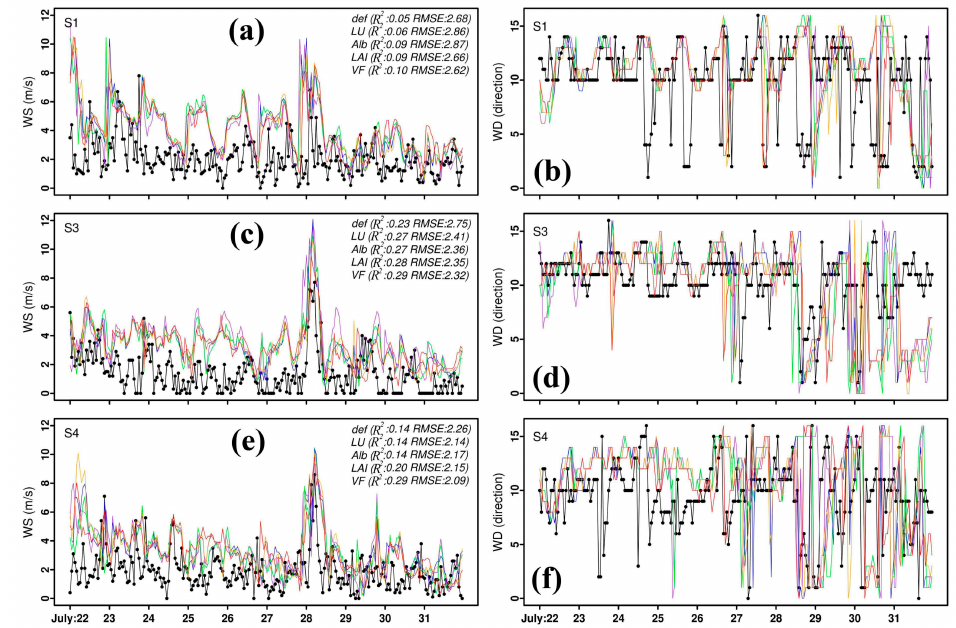
Figure 10. Comparisons of hourly 10 m ( a , c , e ) wind speed (WS) and ( b , d , f ) wind direction (WD) between observations and five simulations at three stations (S1, S3, S4)